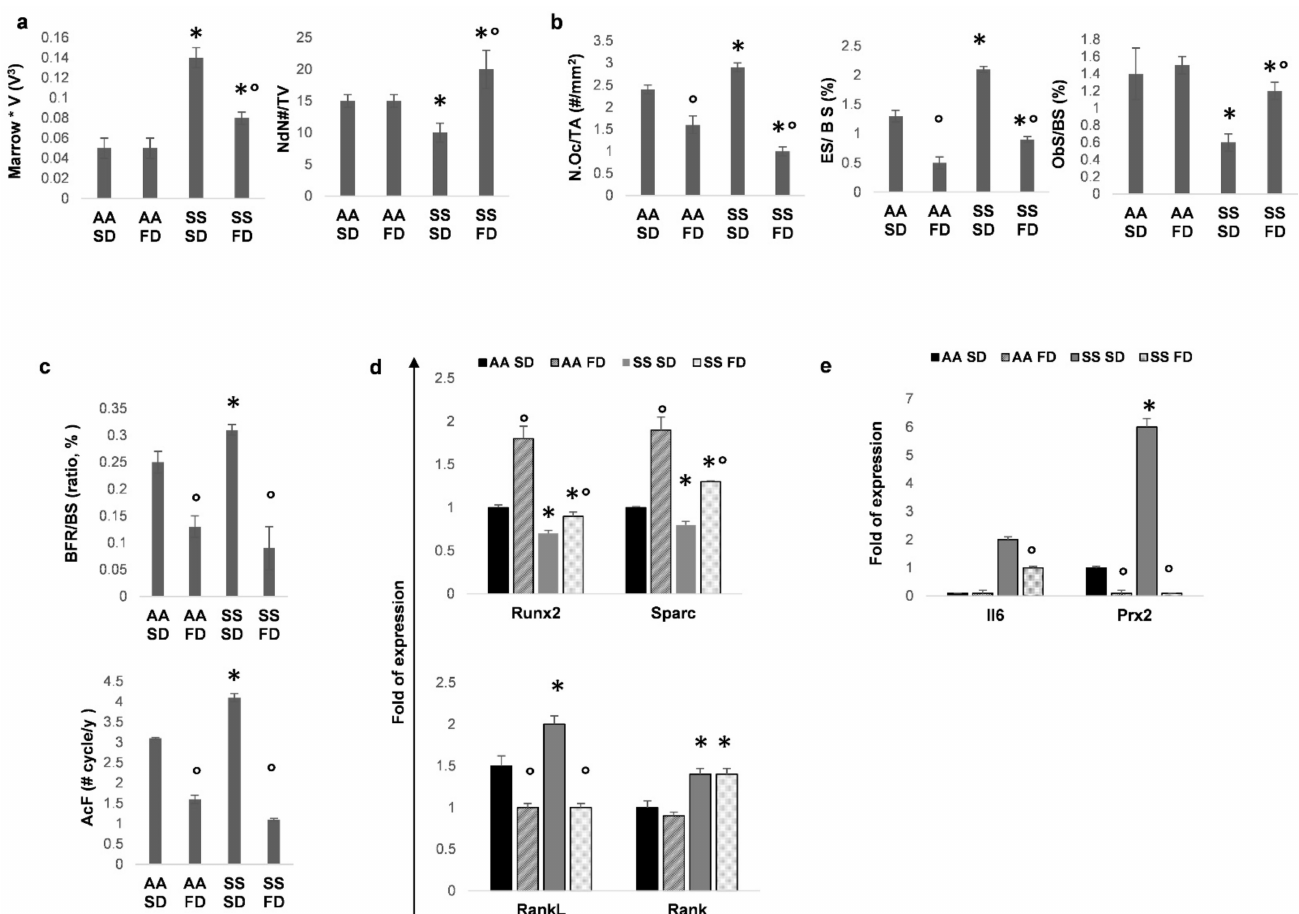
Figure 1. FD improves bone microarchitecture and reduces bone turnover in humanized sickle cell mice under normoxia. Quantitative histomorphometric analysis of distal femur of healthy (AA) and sickle cell (SS) mice under either SD or FD supplementation under normoxia. ( a ) Marrow Star Volume (Marrow*V) and increased Node Number (NdN#/TV) in healthy (AA) and sickle cell (SS) mice under either SD or FD supplementation. ( b ) Osteoclast number (N.Oc/TA), activity (ES/BS) osteoblastic activity (ObS/BS) in healthy (AA) and sickle cell (SS) mice under either SD or FD supplementation. ( c ) Bone Formation Rate (BFR/BS) and Activation Frequency (AcF), data are shown as mean ± standard deviation (SD). ( d ) Real-time PCR analysis of bone Runx2, Sparc, RankL, Rank expression in healthy (AA) and sickle cell (SS) mice under either SD or FD supplementation. ( e ) Real-time PCR analysis of interleukin- 6 (Il-6) and peroxiredoxin-2 (Prx2) bone expression in healthy (AA) and sickle cell (SS) mice under either SD or FD supplementation. ( a – e ) Data are shown as mean ± standard deviation (SD) ( n = 4; 2 females and 2 males). * p < 0.05 compared to AA; ◦ p < 0.05 compared to